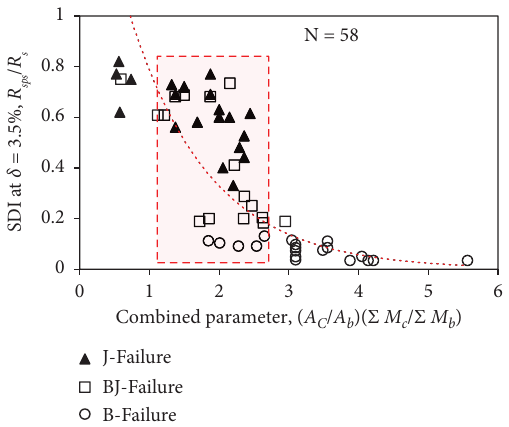
Figure 1: Correlation between the joint shear deformation index (SDI) and combined parameter.